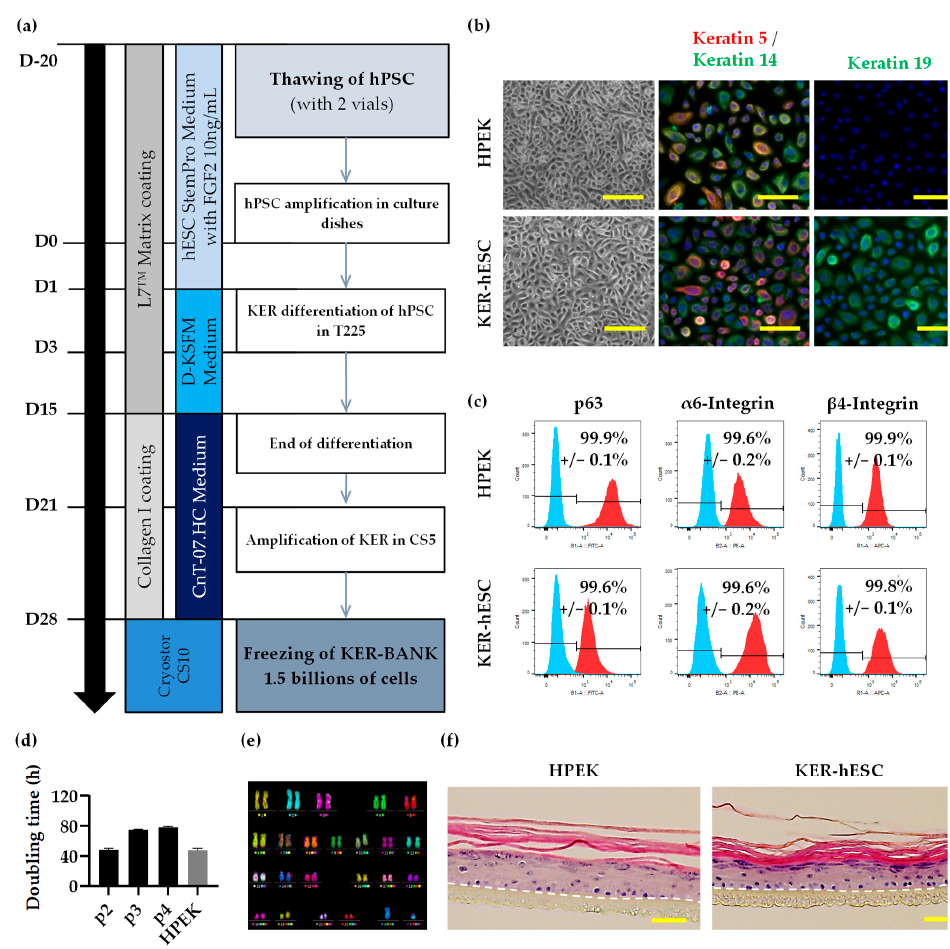
Figure 1. Characterization of a homogeneous and functional population of keratinocytes derived from hESC. ( a ) Schematic representation of the clinical compatible protocol design for differentia- tion of hPSC into keratinocytes. ( b ) Microscopic observation of HPEKp3 and KER-hESCp2 morphol- ogy (Scale bars: 200 μ m) and immunocytochemistry analysis of keratin 5, keratin 14, and keratin 19 (Scale bars: 100 μ m). ( c ) Flow cytometry analysis of p63, α 6-Integrin, and β 4-Integrin expression (in red). Staining with isotypic antibody (in blue) was performed as control. ( d ) Doubling time of KER- hESC from passage 2 (p2) until p4 and HPEKp3. ( e ) Karyotype analysis of KER-hESC (46:XY) by mFISH staining. ( f ) Eosin-Hematoxylin staining of epidermal reconstitution on polycarbonate mem- brane (Scale bars: 100 μ m). 2.7. Fibroblast and Myofibroblast Differentiation and Culture After amplification, hPSCs were passaged and seeded in a new L7 matrix-coated flask (225 cm 2 ) at 1 clump per cm 2 with StemPro ® hES SFM medium supplemented with stabilized FGF2 for one day (D0). The medium was replaced by fibroblast medium (CnT-